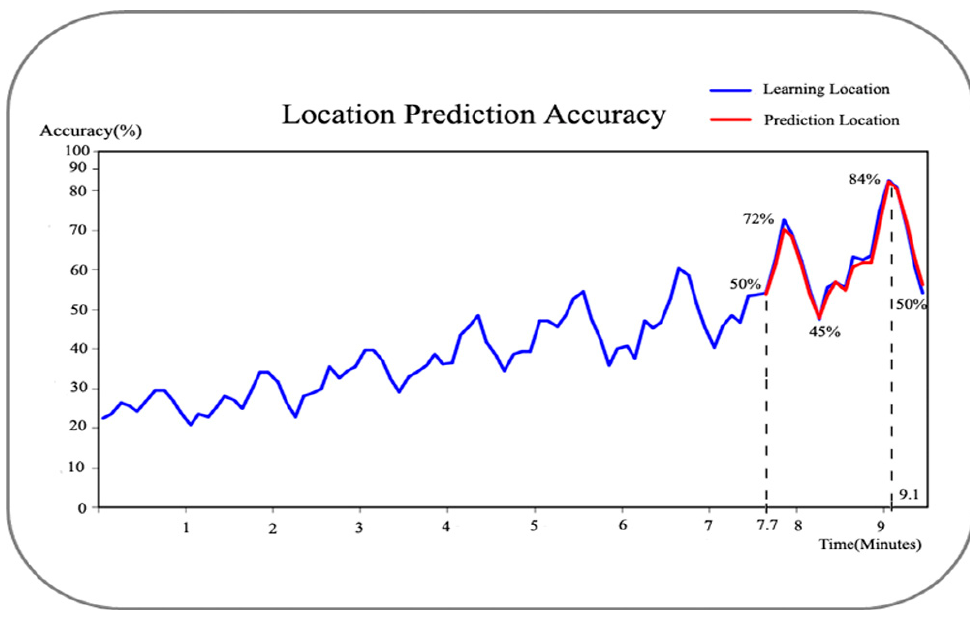
Figure 10. Accuracy of the position prediction system based on pattern recognition.